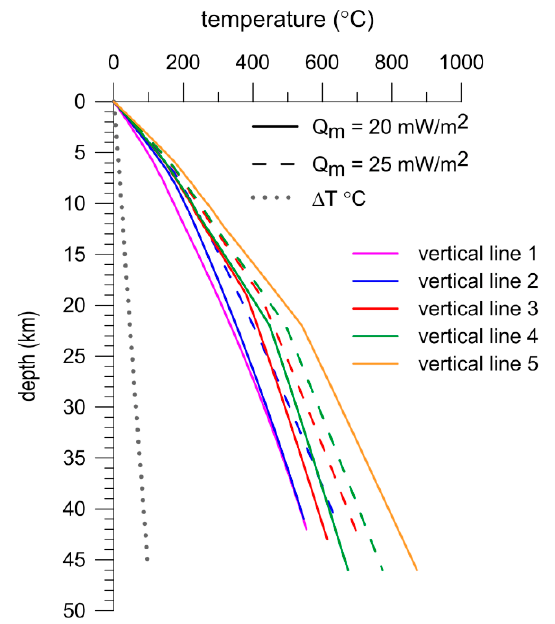
Figure 6. Calculated geotherms corresponding to the five vertical lines shown in Figure 3 for Q m of 20 mW / m 2 (solid lines) and 25 mW / m 2 (dashed lines, calculated for verticals 2 to 4 only). The dotted gray line indicates the maximum change of temperature ∆ T (z) between the two geotherms with Q m of 20 and 25 mW / m 2 computed for the three vertical lines shown in Figure 4 .